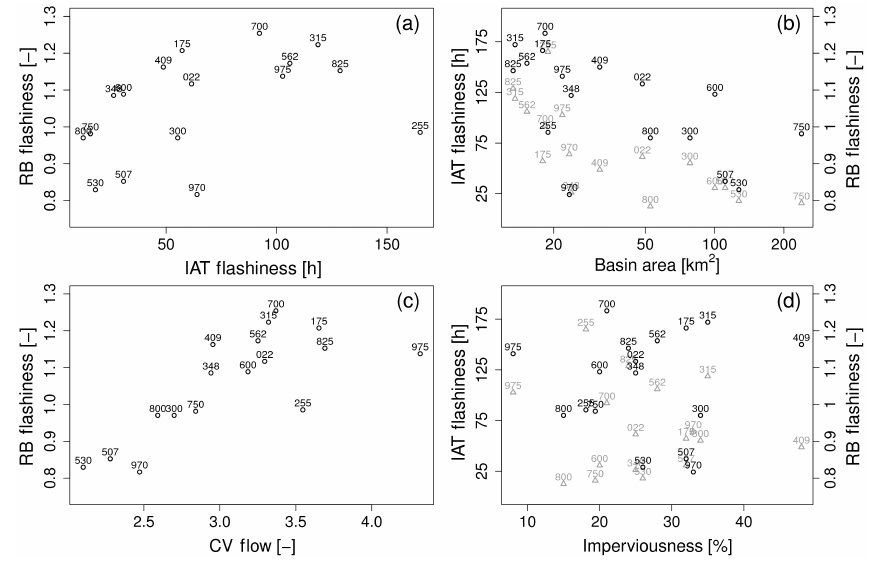
Figure 10. Scatter plots of flashiness versus basin area and imperviousness, for all gauges. Grey triangle symbols represent inter-amount times, black circles represent